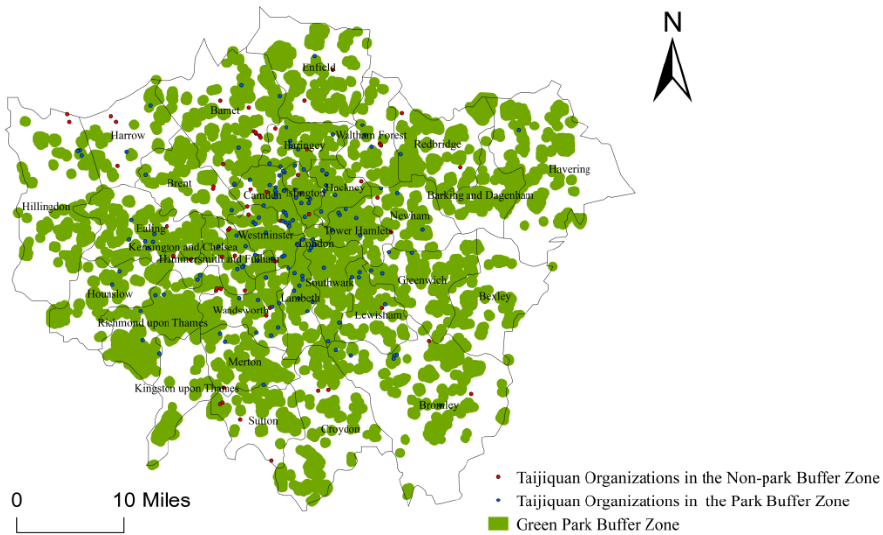
Figure 6. Green Space Map for the Spatial Distribution of Taijiquan Organizations in London.